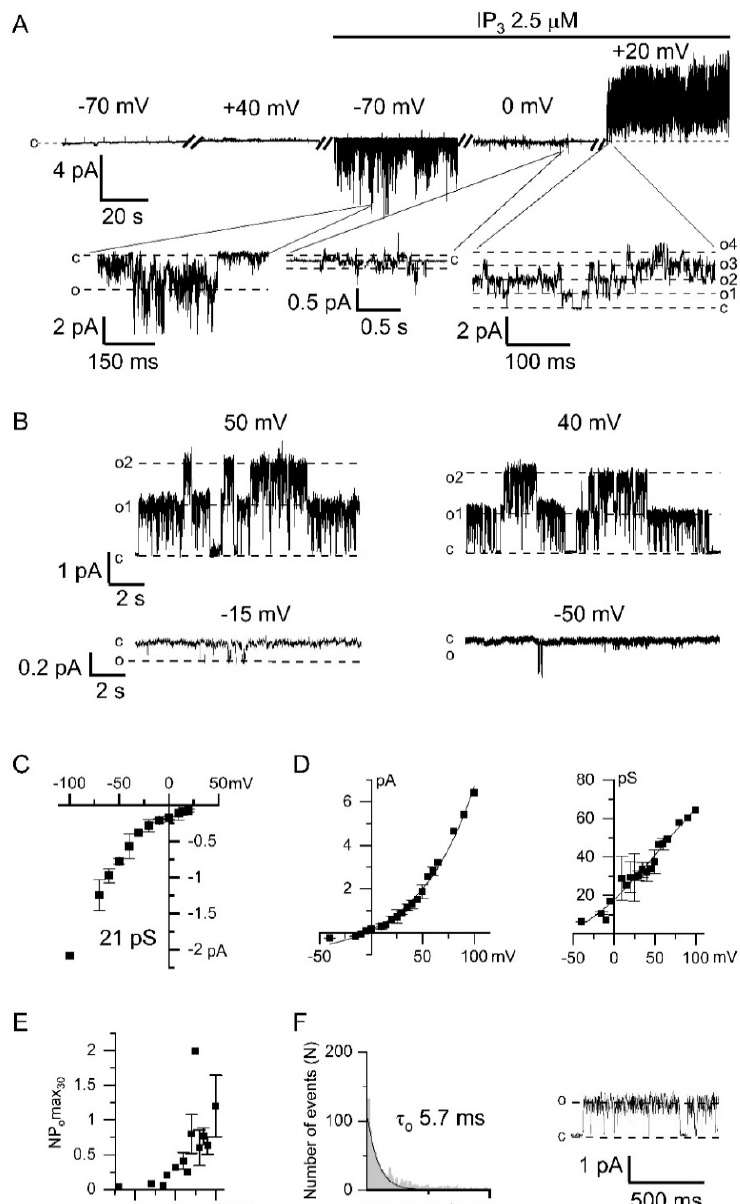
Figure 1. Electrophysiological properties of endogenous Ca 2+ -activated chloride channels (CaCC) in HEK293 cells. ( A ) Representative recording of currents, registered at different membrane potentials, within one experiment before and after bath application of 2.5 µ M IP 3 (inositol 1,4,5-trisphosphate). The expanded panels depict inward IP 3 -induced Ca 2+ currents followed by Ca 2+ -activated outward currents. The baseline was appropriately adjusted for voltage switches. ( B ) Examples of CaCC current recordings obtained after IP 3 -induced Ca 2+ entry at different membrane potentials. ( C ) Current–voltage relationship of IP 3 -induced TRPC1 (transient receptor potential-canonical) Ca 2+ currents ( n = 3–11). The linear fit to the data points from − 100 to − 40 mV yielded single channel conductance ( γ ) of 21 pS. ( D ) Left : Current–voltage relationship of Ca 2+ -activated chloride channels recorded in panel B ( n = 3–4). Right : The dependence of the conductance of Ca 2+ -activated chloride channels on the membrane potential. ( E ) The dependence of the activity of Ca 2+ -activated chloride channels, expressed as NPomax30, on the membrane potential ( n = 4). ( F ) An open-time histogram of CaCC channel was constructed from 2563 single-channel opening events. Single exponential fit (solid line) corresponds to a time constant of 5.7 ± 0.3 ms. The current trace demonstrates a typical fragment of the current recording used for the histogram at +30 mV and filtered at 1 kHz.